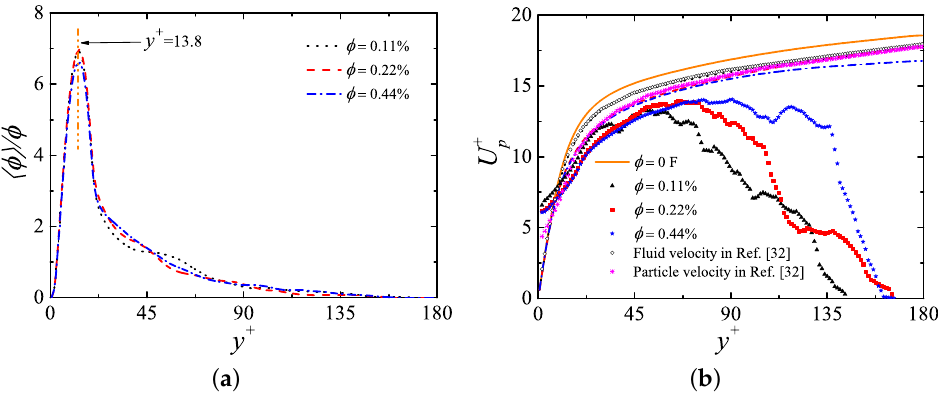
Figure 7. ( a ) Distributions of particle local volume fraction as function of the wall-normal locations and ( b ) particle mean streamwise velocity profiles. In ( b ), the corresponding profiles of the fluid phase are also shown for comparison (lines). Besides, mean velocity profiles of the fluid and the particles in Ref. [32] (see Figure 7a in their paper) are also added for